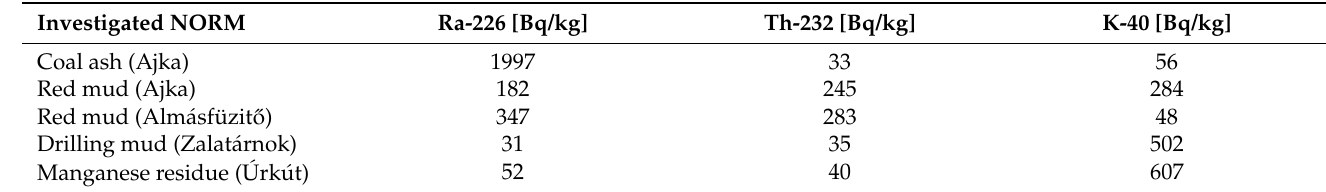
Table 2. Activity concentration of the radionuclides in the investigated NORMs.